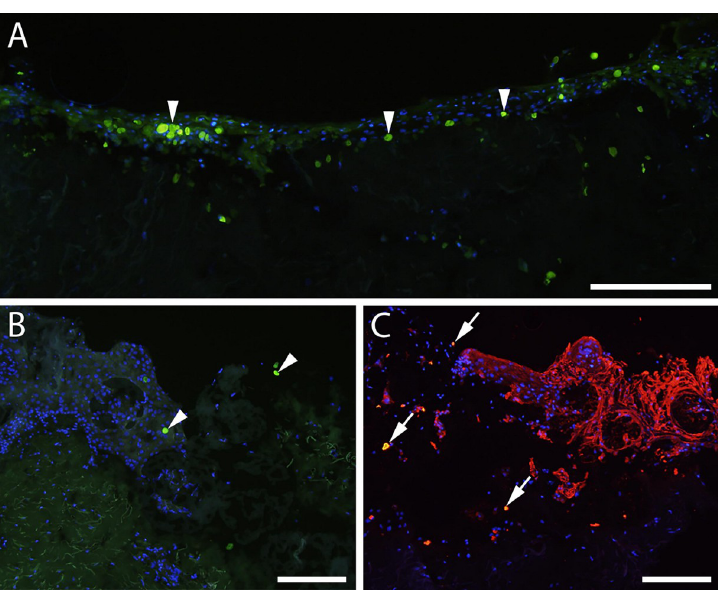
Fig 4. Transplantation of CFSE-stained keratinocytes to ex vivo wounds. (A) 5(6) carboxyfluorescein-N- hydroxysuccinimidyl ester (CFSE)-stained keratinocytes are incorporated into the neoepidermis in a fully re- epithelialized ex vivo wound seven days post transplantation, seen as green stained cells. (B) CFSE-stained keratinocytes (green) on microcarriers in an ex vivo wound seven days post transplantation. Arrowheads indicate CFSE-stained keratinocytes. (C) CFSE-stained keratinocytes on microcarriers in an ex vivo wound 21 days post transplantation. Double staining with CFSE and antibodies against cytokeratin detected with red fluorescent secondary antibodies can be identified by the yellow color (arrows), confirming that the stained cells are transplanted keratinocytes. Scale bars = 200 μ m.